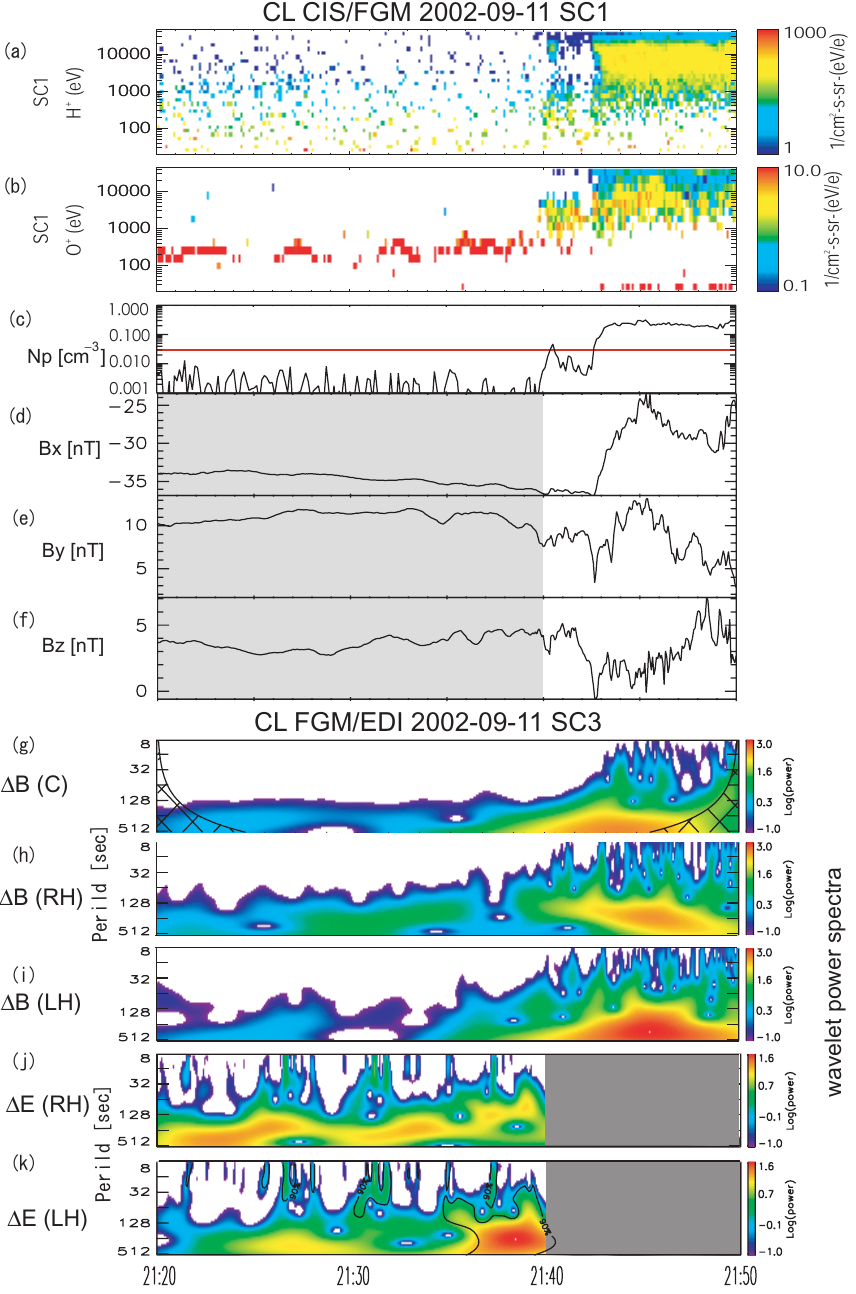
Fig. 1. Cluster observation on 11 September 2002. Energy-time diagram of (a) protons and (b) O + , (c) proton density, (d–f) magnetic field components in aberrated GSM coordinates (SC1). Red line in (c) indicate N P =0.03cm − 3 for statistical criteria. Wavelet power spectra of (g– i) magnetic field fluctuations and (j–k) electric field fluctuations (SC 3) are shown in color scales. Each panel corresponds to compressional (C), right-hand (RH) and left-hand (LH) components, respectively. Cross-hatched regions on either end indicate the “cone of influence” where edge effects become important (not shown in h, i, j, k, but same as g). Gray shaded areas in (d–f) are lobe region and shown in detail in Fig. 2. Gray shaded areas in (j–k) are the intermittent data lack intervals of EDI.